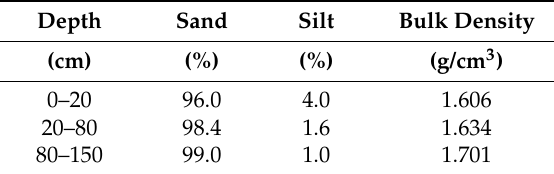
Figure 2. Hydrogeological map of the field study. Table 1. Soil texture information of different layers.